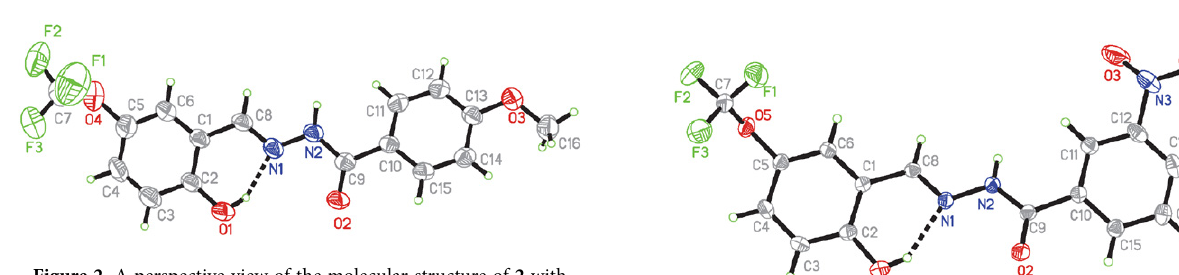
Figure 1. A perspective view of the molecular structure of 1 with the atom labeling scheme. Thermal ellipsoids are drawn at the 30% probability level. Hydrogen bond is shown as a dashed line.